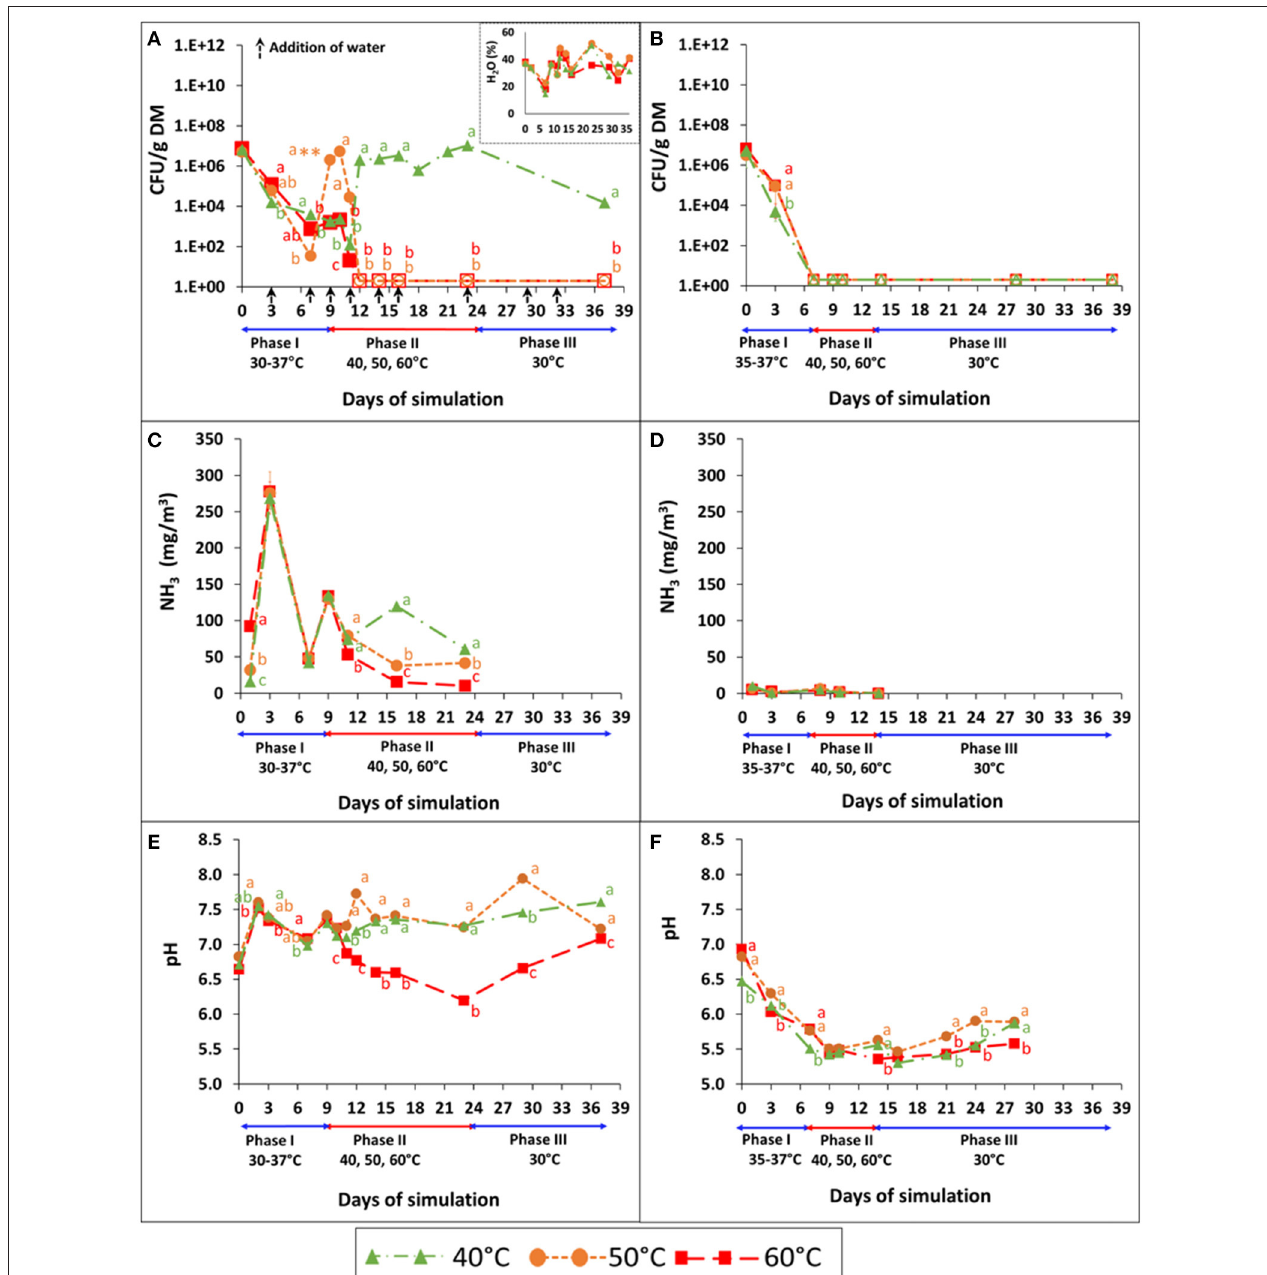
FIGURE 3 | Persistence of S . Infantis (A,B) , emissions of NH 3 (C,D) , and pH dynamics (E,F) in broiler litter (BL), during controlled aerobic and anaerobic simulations performed in six reactors (one reactor for each treatment). The water content was monitored and adjusted under aerobic conditions ( A –inset). Mesophilic temperatures were maintained between 30 and 37 ◦ C in phase I and then increased to 40, 50, or 60 ◦ C in phase II until Salmonella was reduced below the detection limit. Finally, in phase III, the contents of each of the reactors were transferred to 30 ◦ C for 2 more weeks. The airflow was constant (5l min − 1 ) during the simulations of aerobic conditions. Error bars represent the standard deviations of triplicate analyses performed on a unified sample collected from each reactor. Empty symbols indicate values below the detection limit after enrichment (1–2 CFU g − 1 dry matter); **a value above plate countability. Letters denote significant differences between treatments at time intervals (Tukey-Kramer HSD; P ≤ 0.05). DM, dry matter.